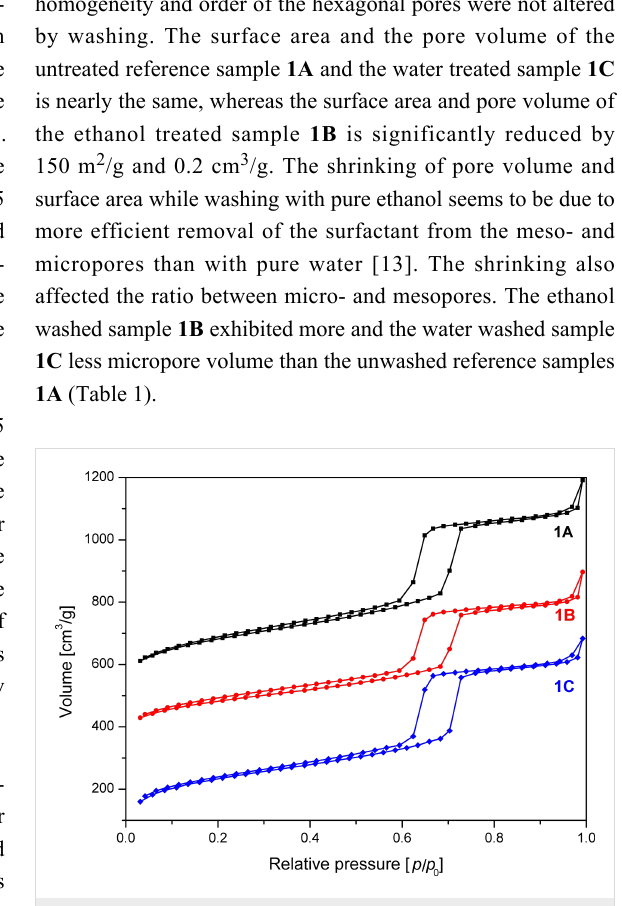
Figure 1: N 2 adsorption/desorption isotherms of SBA-15 unwashed ( 1A ), after washing with 30 mL ethanol ( 1B ) and 30 mL water ( 1C ). The isotherms are offset by 450 ( 1A ) and 300 ( 1B ) cm 3